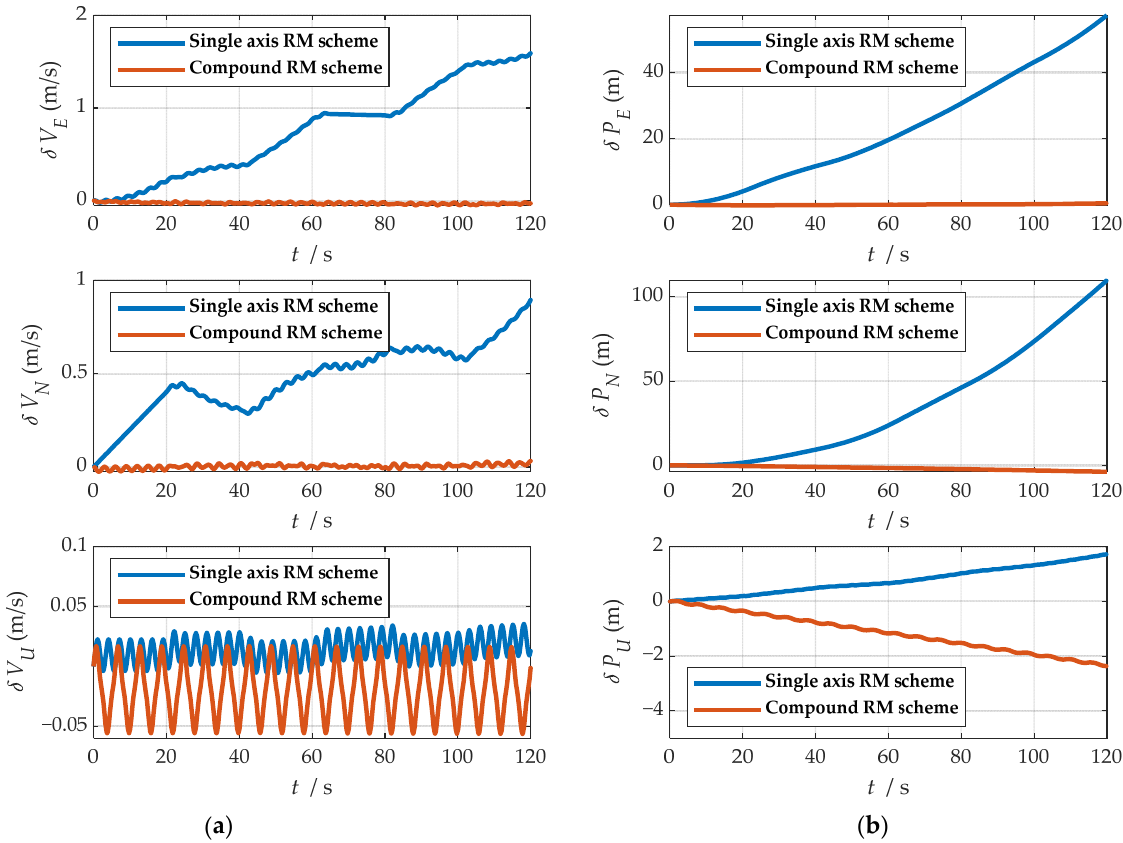
Figure 16. Comparison of velocity and position error in three directions: ( a ) comparison of velocity error in three directions; ( b ) comparison of position error in three directions.